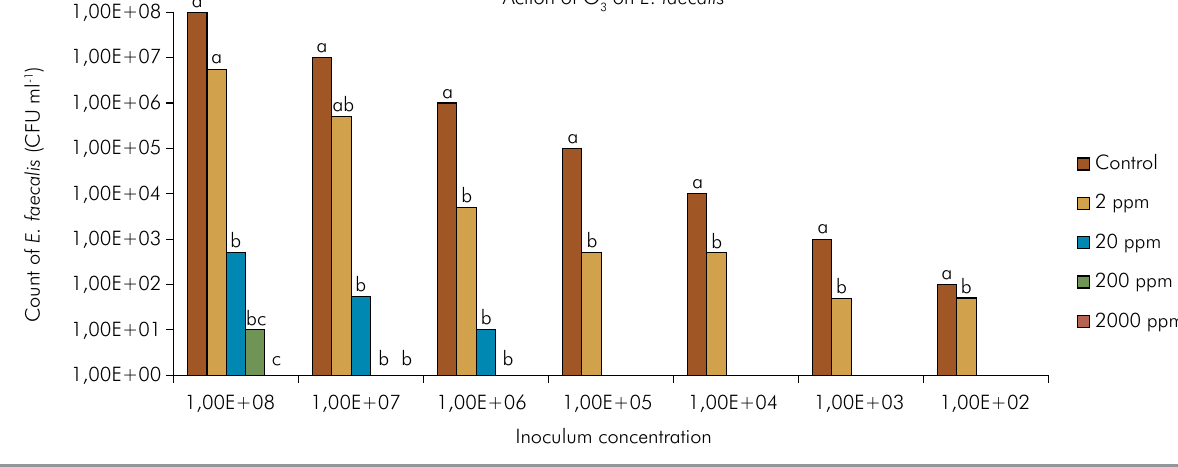
Figure 3. Inhibition of E. feacalis growth in logarithmic scale (log lower case letters (for comparasions between O